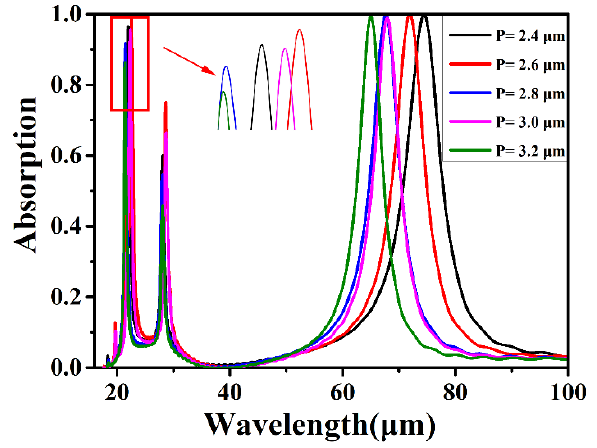
Figure 4. Absorption spectrum of “ancient coin”-type absorber under different periods P .